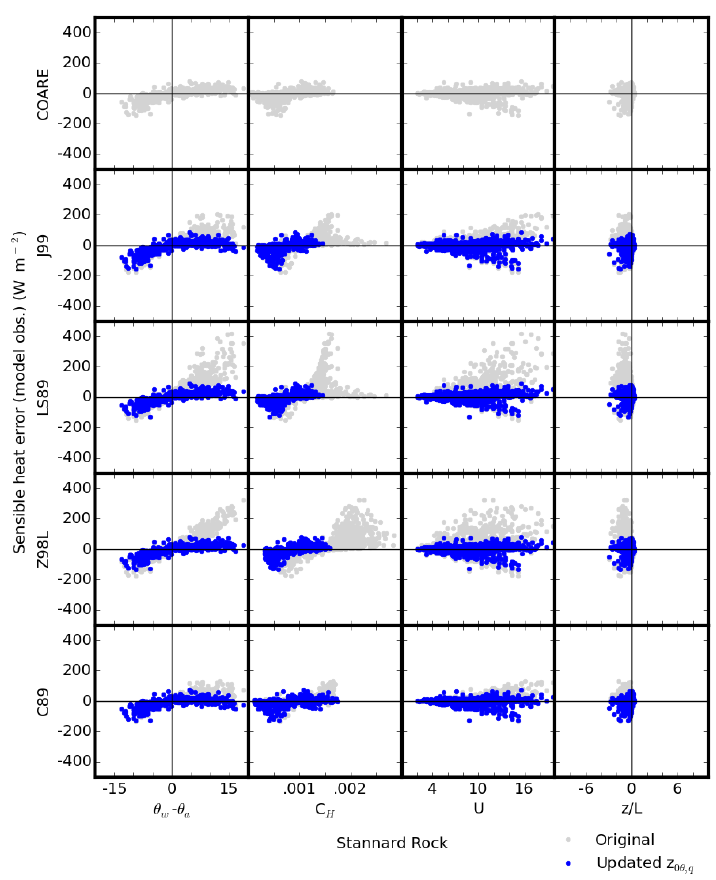
Figure 11. Errors in daily mean sensible heat flux ( y axis) versus potential temperature difference between the water’s surface and air at the sensor height θ w − θ a ( ◦ C), transfer coefficient C H (–), wind speed U (ms − 1 ), and stability factor z/L ( x axis) for the five algorithms at Stannard Rock. Gray and blue dots indicate the results with the original and updated z 0 ,q formulae,